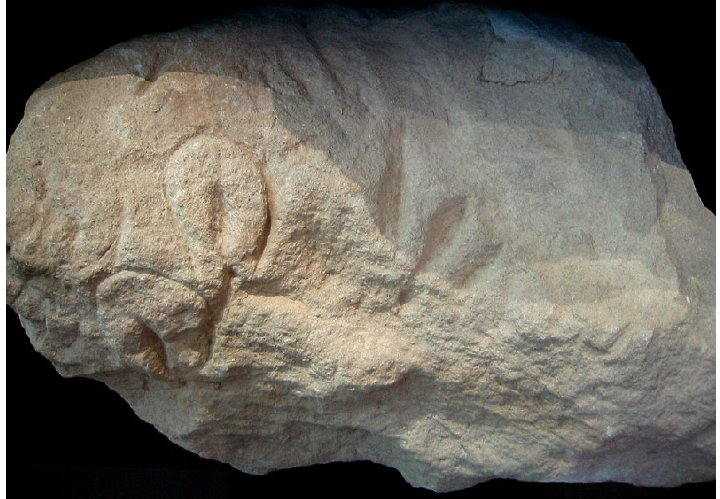
Figure 13. Engraved limestone block, 60 cm long, from the Aurignacian of Abri Cellier, Dordogne, France.